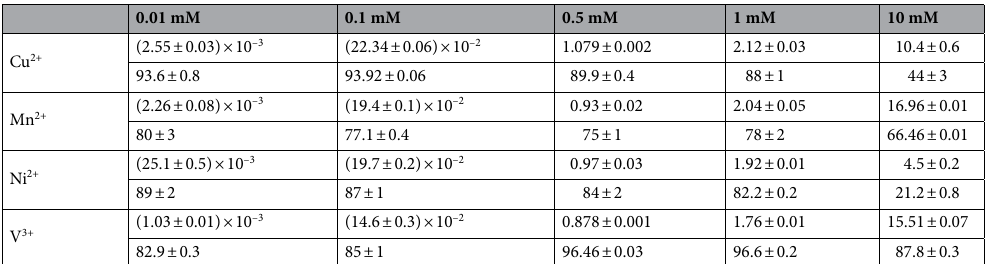
Table 2. Metal adsorption at pH 4 calculated as the difference between the initial and final concentration of the loading solution. For each condition, the results are reported in mg·g −1 of the matrix above and the percentage below ( # ). The standard deviation is reported. # The desorption concentration of metal ions from the byssus matrix in 2 ml of the buffer-only solutions are reported in table